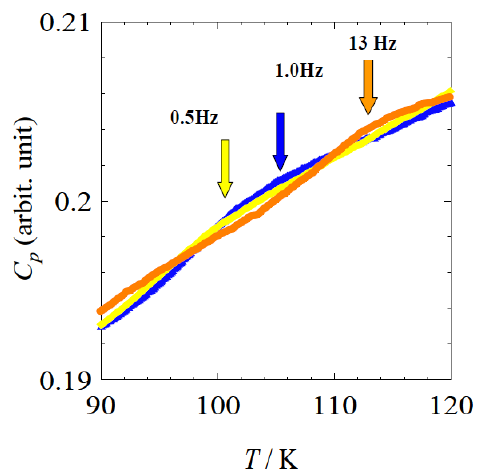
Figure 5. Temperature dependences of ac heat capacity of κ -(BEDT-TTF) which detect hump-like anomalies in association with freezing of ethylene dynamics in BEDT-TTF molecules in different